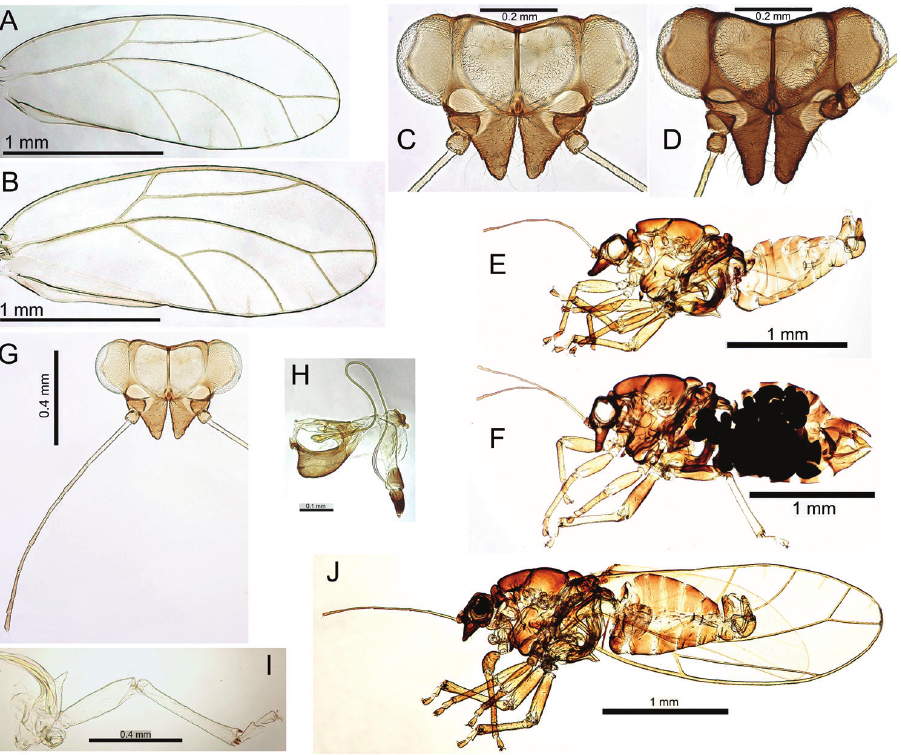
Figure 42. Pariaconus pele sp. n. A–B fore wing: A form pele B form kohalensis C–D head: C form pele D form kohalensis E–F form kohalensis : E male F female with abdomen full of eggs G head and antenna H proboscis I hind leg J male, form pele